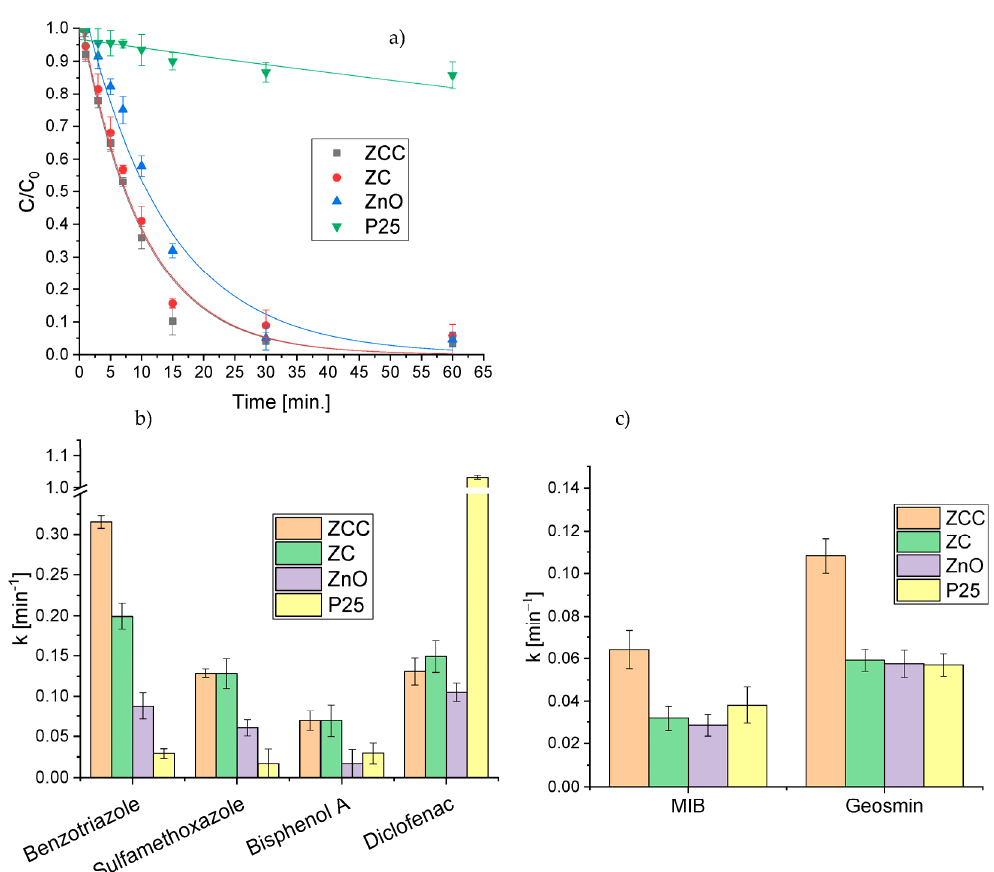
Figure 4. Comparison of photocatalytic mercury removal profiles ( a ) and pseudo-first order calculated kinetic constants of CECs degradation ( b ) and MIB and geosmin degradation ( c ) with the different photocatalysts in the mixture of pollutants.